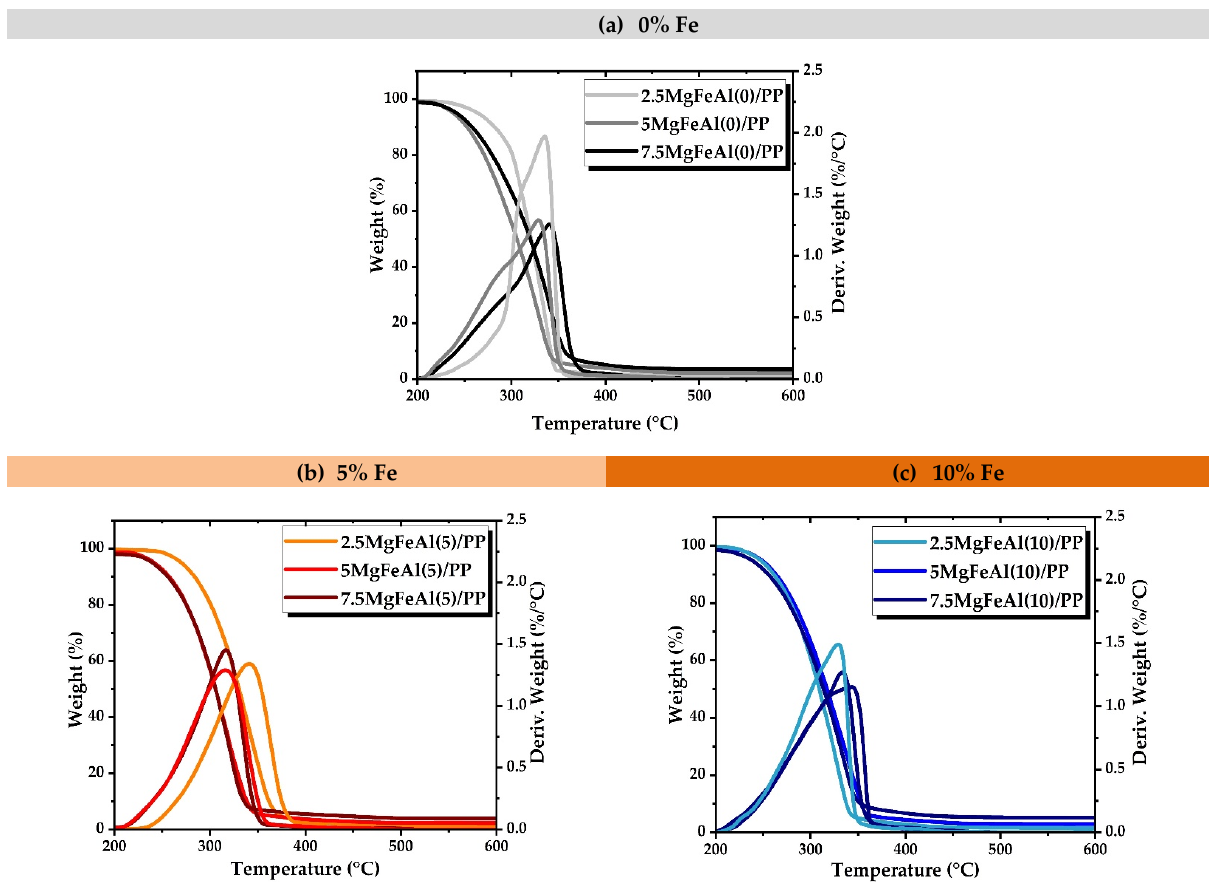
Figure 4. TGA analysis of different LDH/PP nanocomposites in air environment showing the effect of different amounts of Fe: ( a ) 0, ( b ) 5, and ( c ) 10%.